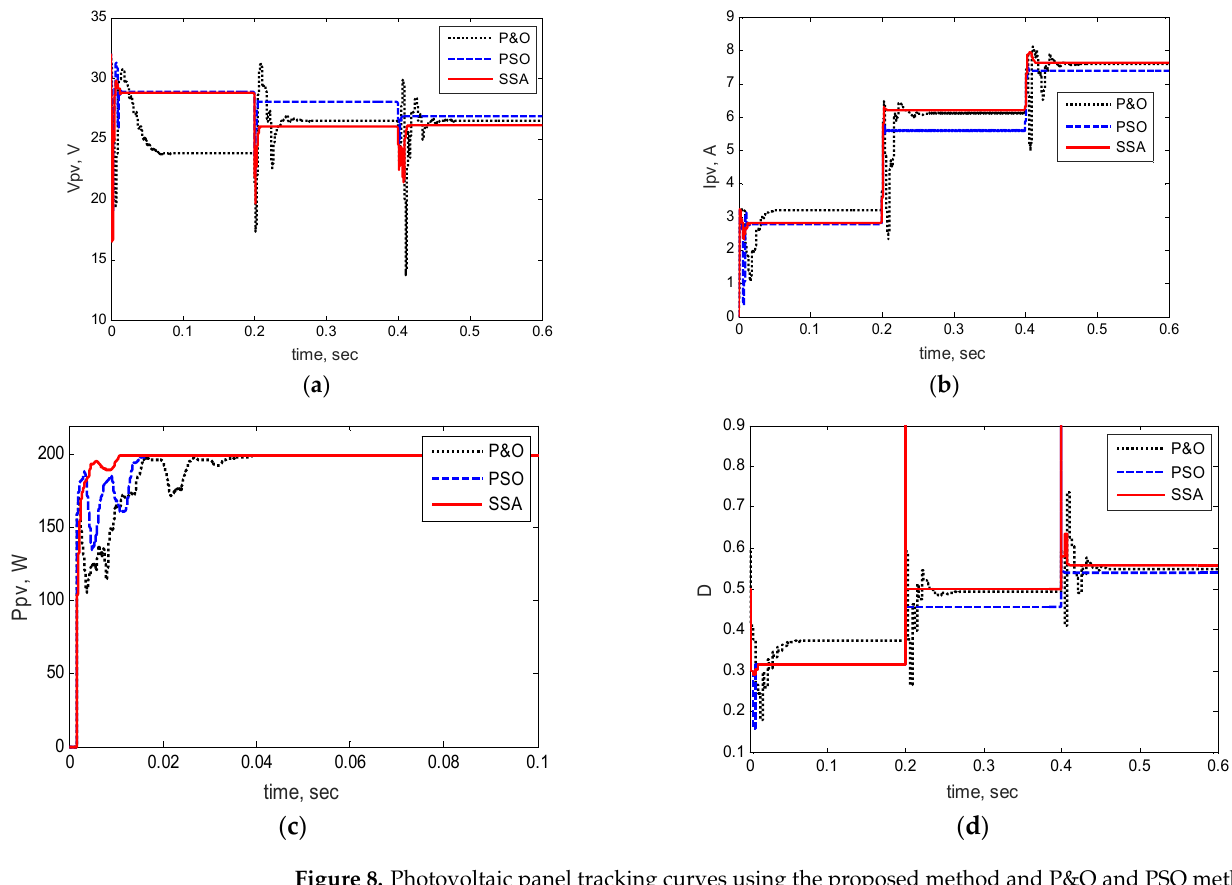
( d ) Figure 7. Photovoltaic panel tracking curves using the proposed method and P&O and PSO meth- ods in STC conditions: ( a ) Vpv, ( b ) Ipv, ( c ) Ppv, ( d ) duty cycle. 5.2. Simulation Results in Variable Radiation Conditions